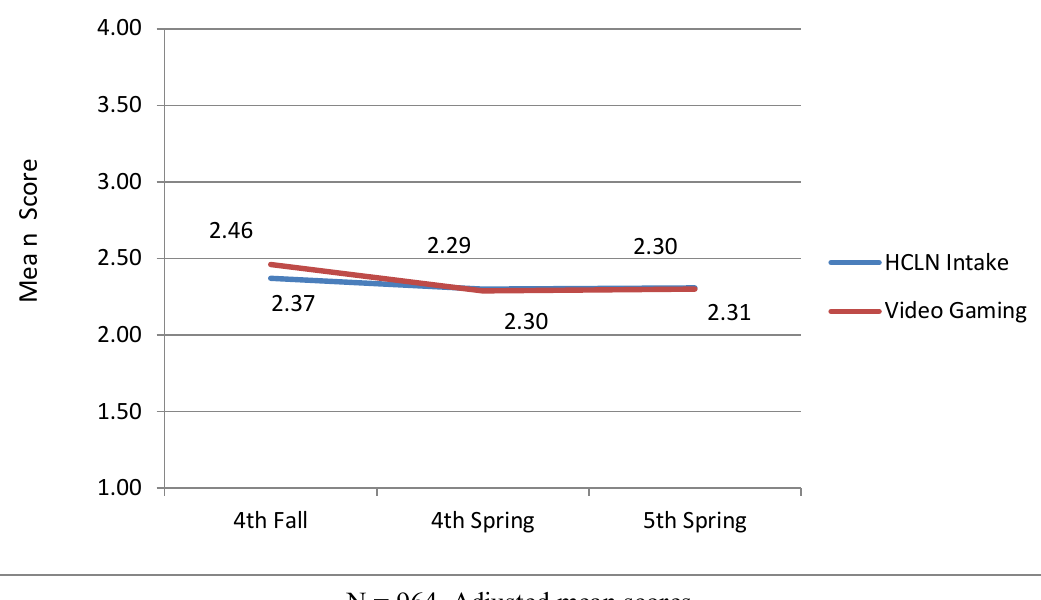
N = 964. Adjusted mean scores. Figure 2. Growth curve model of predictors of HCLN intake and video gaming.